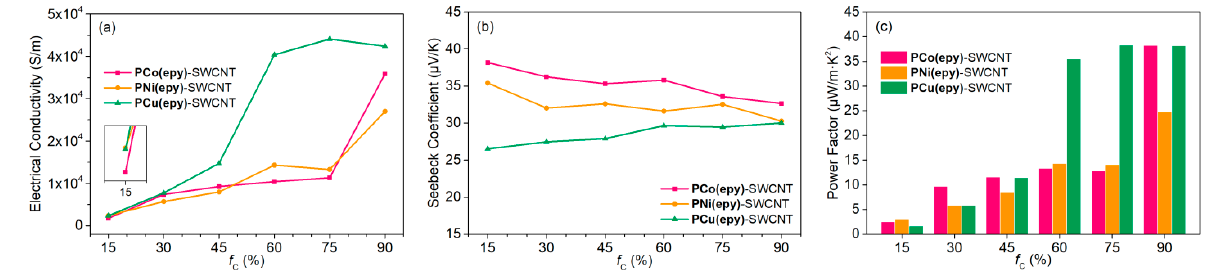
Figure 6. ( a ) Electrical conductivity, ( b ) Seebeck coefficient, and ( c ) PF of the PM(epy) -SWCNT composites at various f C .